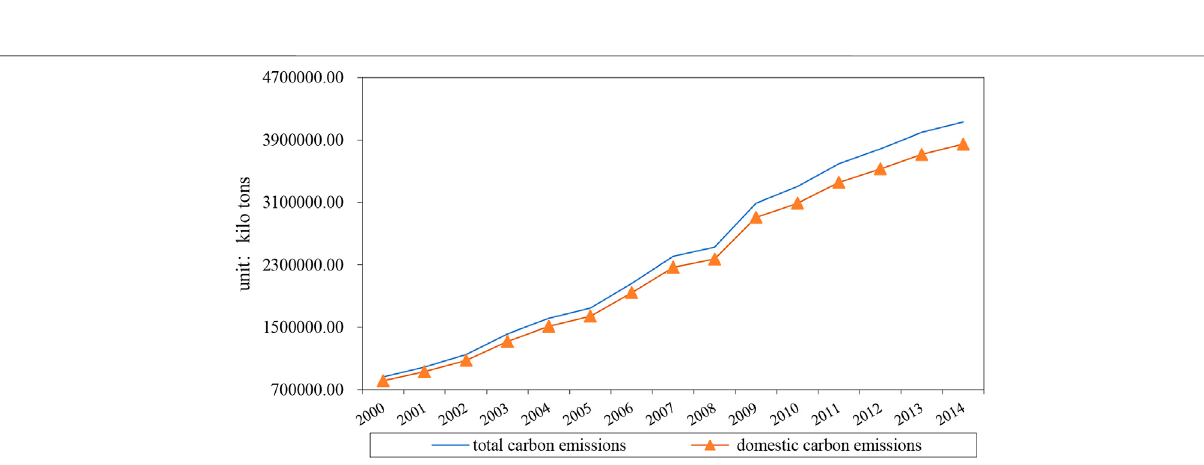
Frontiers in Environmental Science |